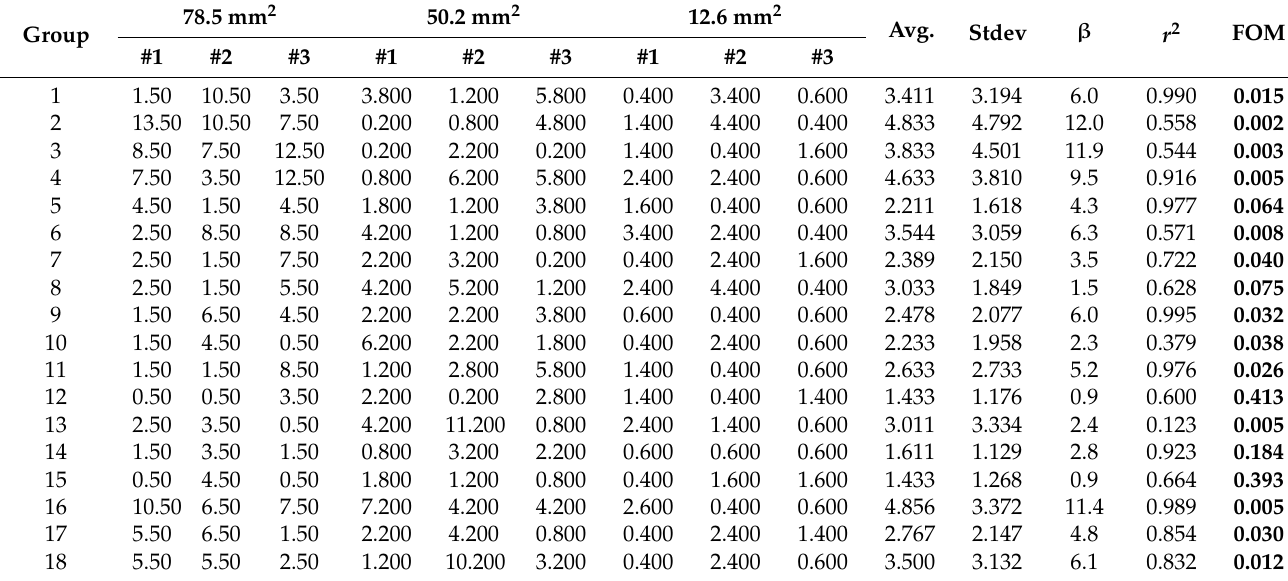
Table 3. The evaluation results obtained from three independent measurements via Equations (1)–(3). The area difference is defined as the difference between the practical survey and theoretical ones (i.e., 78.5, 50.2, or 12.6 mm 2 ). Stdev values are the standard deviations obtained in each group from three trials (cf. Equation